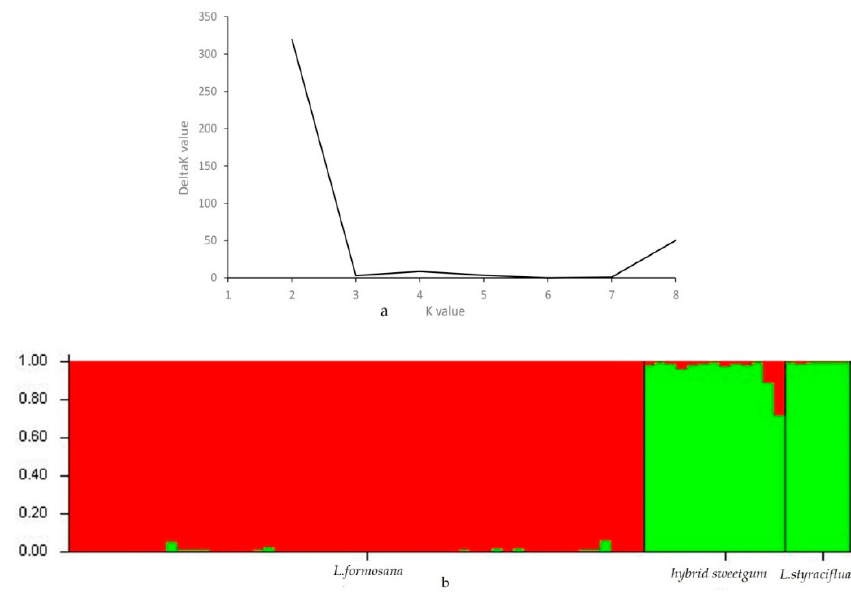
Figure 3. Results of STRUCTURE analysis for 72 Liquidambar individuals based on 20 EST-SSR markers. ( a ) Estimation of population using log probability of data-derived delta K with cluster number (K) ranged from one to eight. ( b ) The 72 individuals are separated into two main gene pools (K = 2), Proportion of green ( L. styraciflua ) in the hybrid sweetgum was much higher than that of red ( L. formosana ), the hybrid was grouped with L. styraciflua .